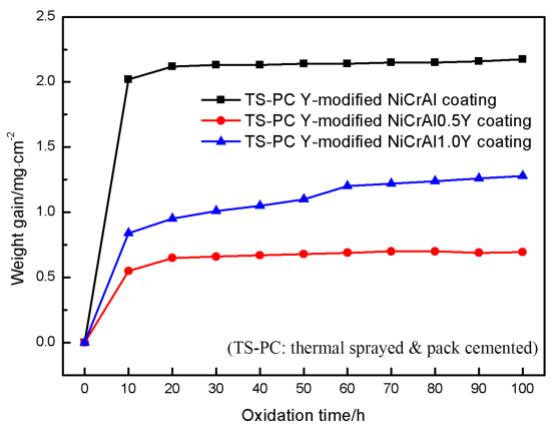
Figure 8. Weight-gain curve of TS-PC Y-modified coatings during constant oxidation at 1100 ° C for 100 h.